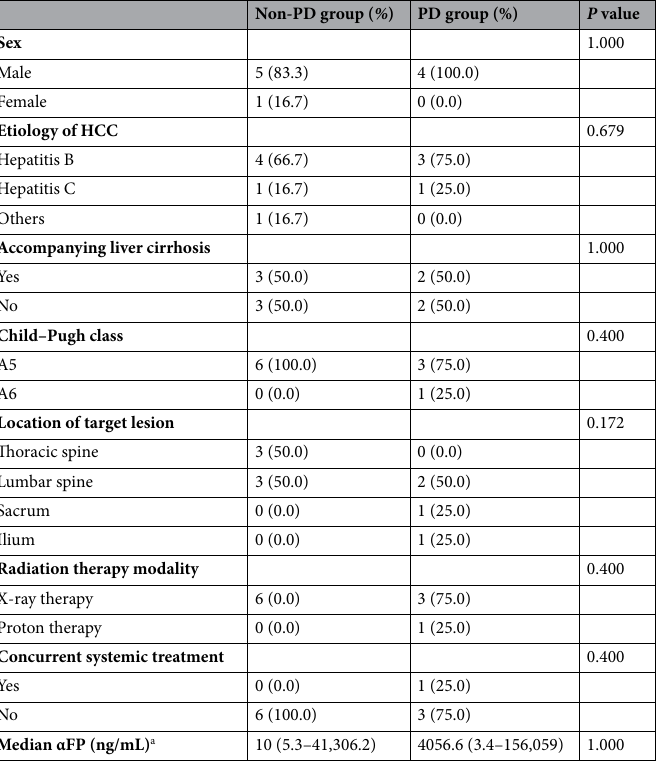
Table 2. Comparison of clinical variables between the non-PD and PD groups. PD progressive disease, HCC hepatocellular carcinoma, αFP alpha-fetoprotein. a Numbers in parentheses are